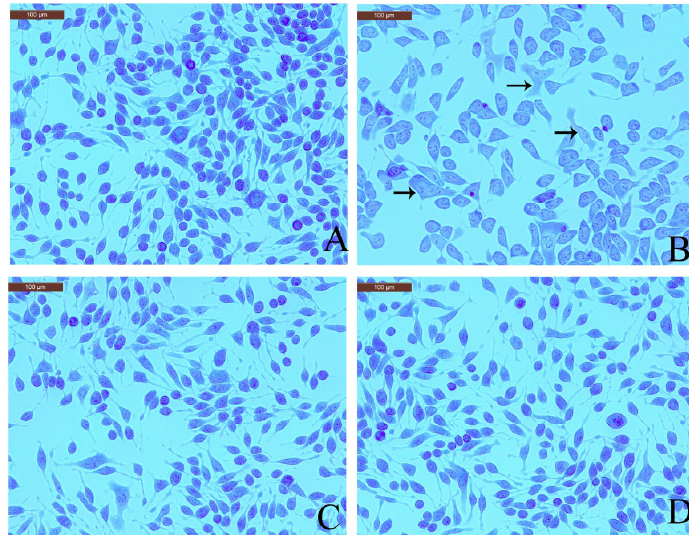
Figure 4. Effects of coptisine with toluidine blue staining in DNP-IgE/HSA-sensitised cells. ( A ) Normal RBL-2H3 cells; ( B ) DNP-IgE/HSA-sensitised RBL-2H3 cells; ( C ) ketotifen fumarate-pretreated RBL-2H3 cells sensitized with DNP-IgE/HSA; ( D ) coptisine (30 µ M)-pretreated RBL-2H3 cells sensitized with DNP-IgE/HSA. Arrows in B indicate that the cells morphology became irregular, and purple granules were released outside of the cells.